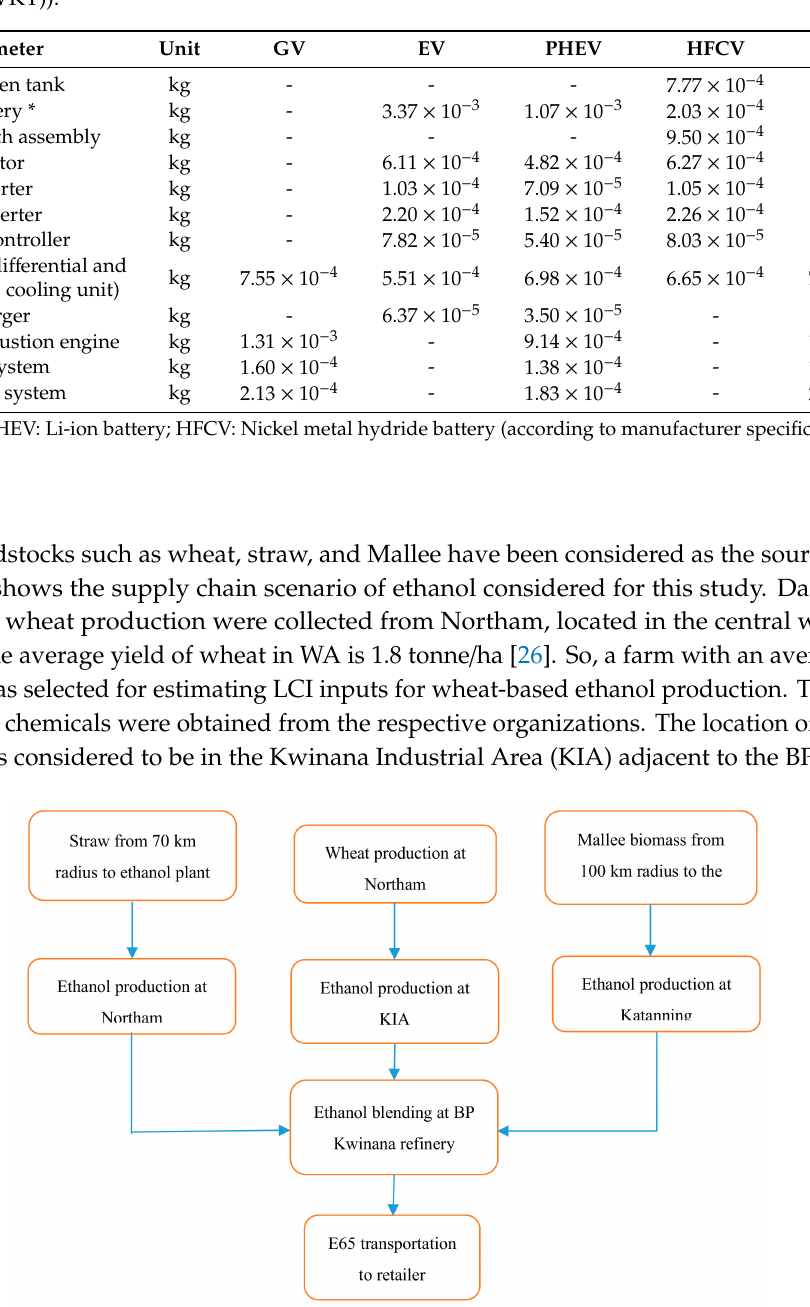
Table 4. Summary of inventory for gasoline vehicle (GV), electric vehicle (EV), plug-in hybrid electric vehicle (PHEV) and Nickel metal hydride battery (HFCV) (functional unit (FU) = per vehicle kilometer travelled (VKT)).